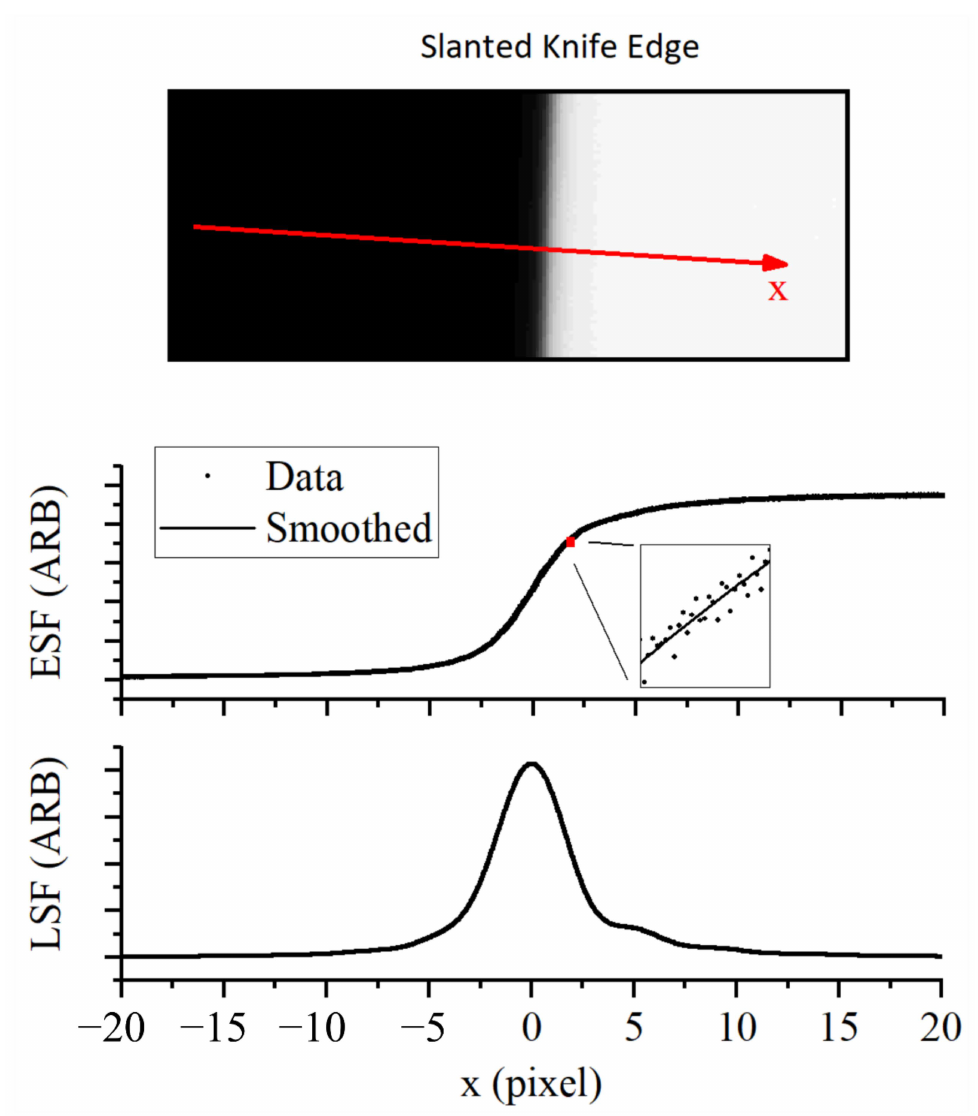
Figure 10. Image of a slanted knife edge used to measure the Edge Spread Function (ESF), the ESF was smoothed and spatially differentiated to provide a measure of the Line Spread Function